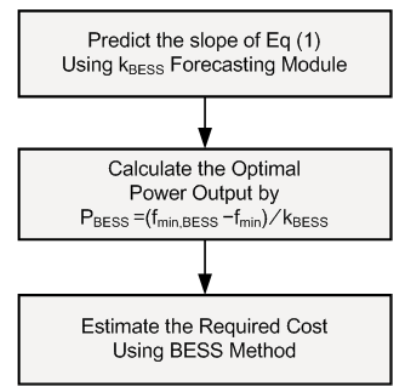
Figure 3. The operation of the BESS method.